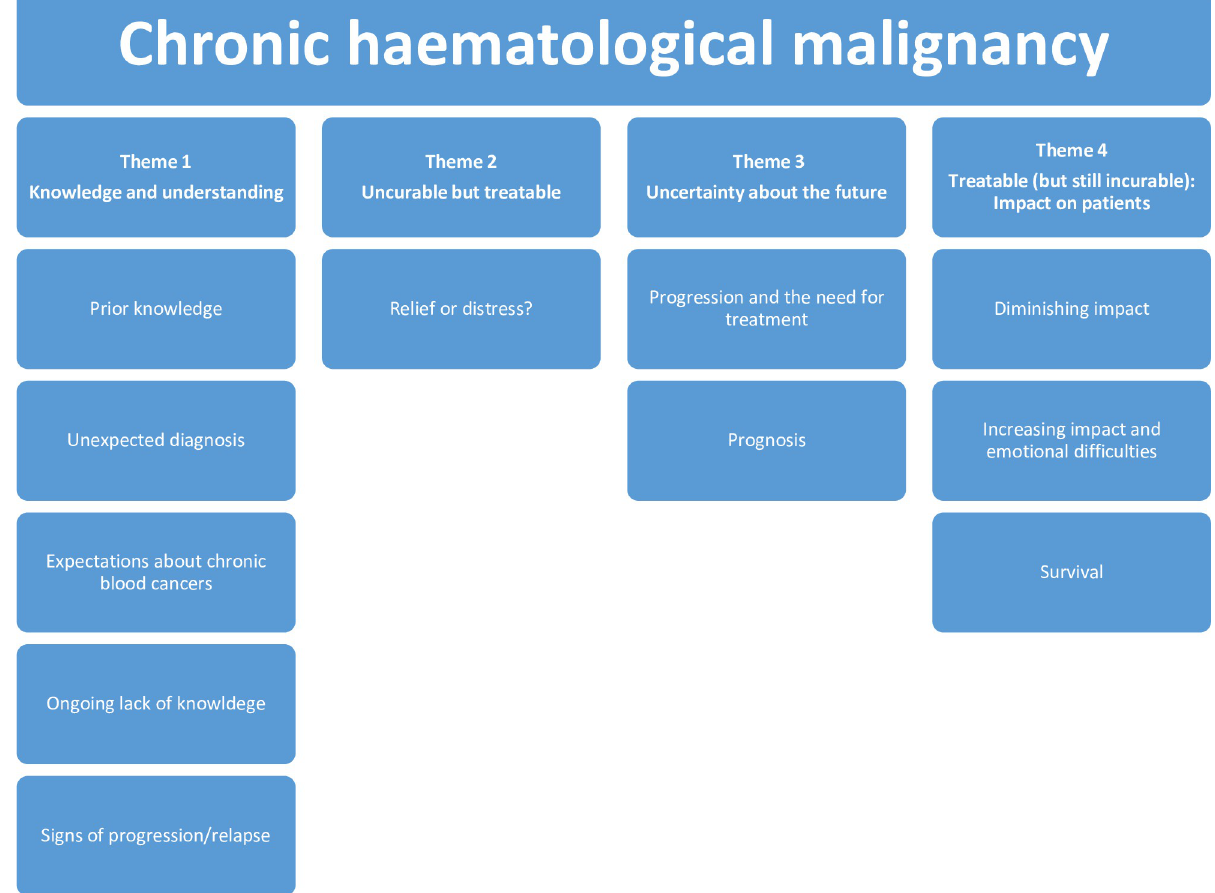
Fig 1. Hierarchical map of themes and